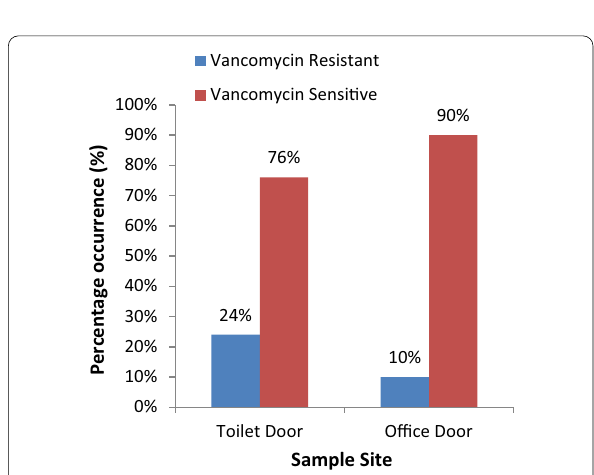
Fig. 5 Vancomycin resistance of test isolates